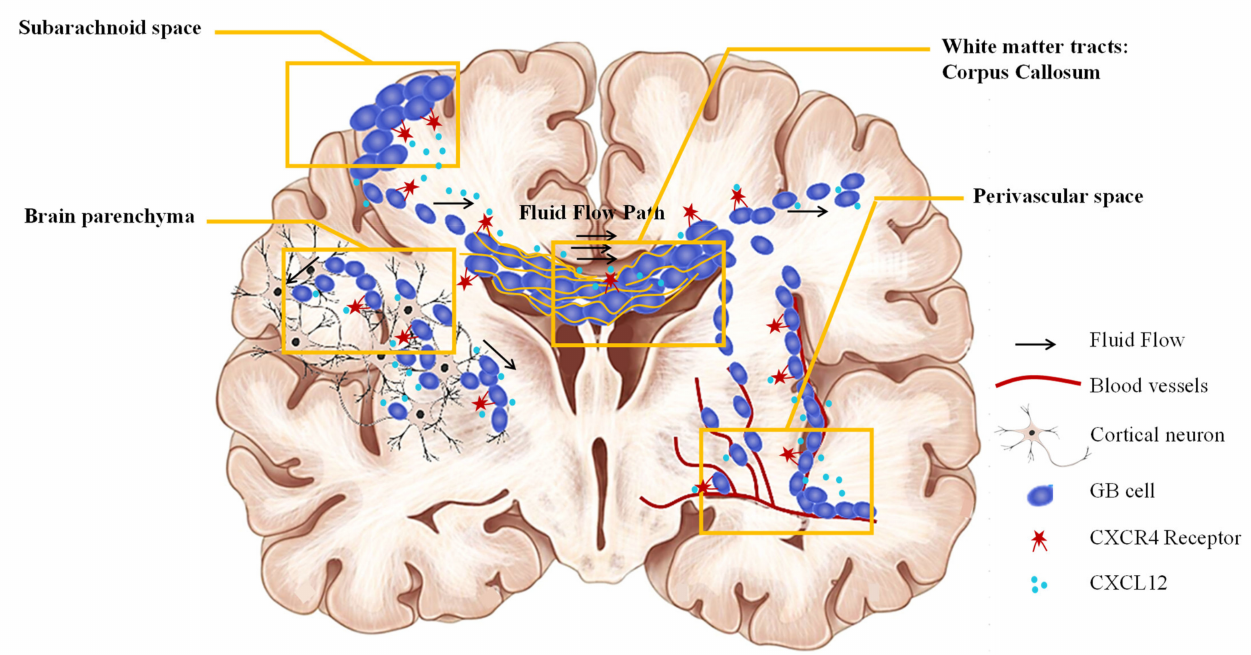
Figure 2. Routes of GBM cells to metastasize in the brain (Adapted from deGooijer et al., 2018